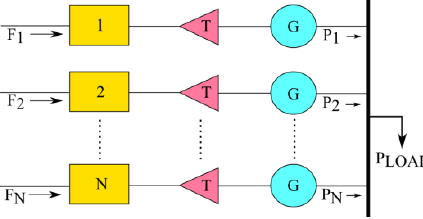
Fig. 2. Single bus-bar connected to N thermal